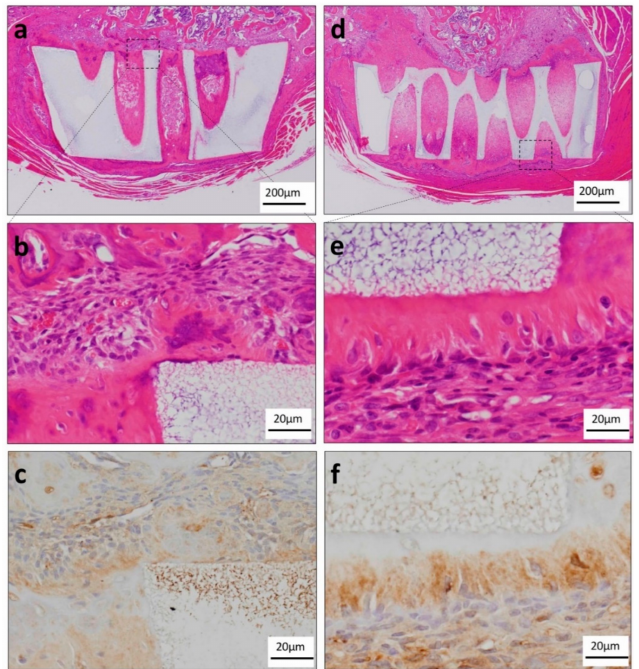
Figure 5. Histological findings in the orthotopic experiments. ( a ) Histological finding of the TGF- β group in low-power magnification. TGC showed massive hard tissue formation as if it was added to the wall of the honeycomb TCP. ( b ) Histological findings of the TGF- β group in high-power magnification. Most of the TGC were observed to be irregularly arranged. ( c ) TGC showed a tendency to di ff erentiate into odontoblasts because they were DSP positive. ( d ) Histological finding of the osteogenic medium group in low-power magnification. TGC showed massive hard tissue formation as if it was added to the wall of the honeycomb TCP. ( e ) Histological finding of the osteogenic medium group in high-power magnification. TGC which di ff erentiated into highly columnar cells formed a single layer hard tissue so as to be added to the honeycomb TCP wall, and showed polarity with the nuclei arranged on the distal side of TCP. ( f ) TGC tended to di ff erentiate into odontoblasts because they were DSP